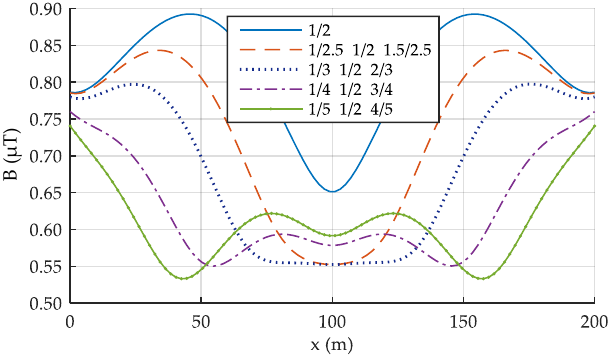
Figure 11. Distribution of the magnetic induction B along the span (1 m above the ground level), with one and with three compactors, varying their longitudinal position (EDS